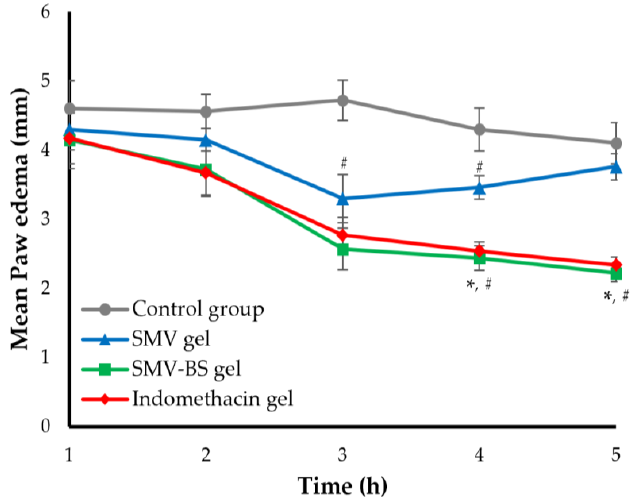
Figure 9. Effects of various SMV formulations on mean hind paw edema. Data are presented as